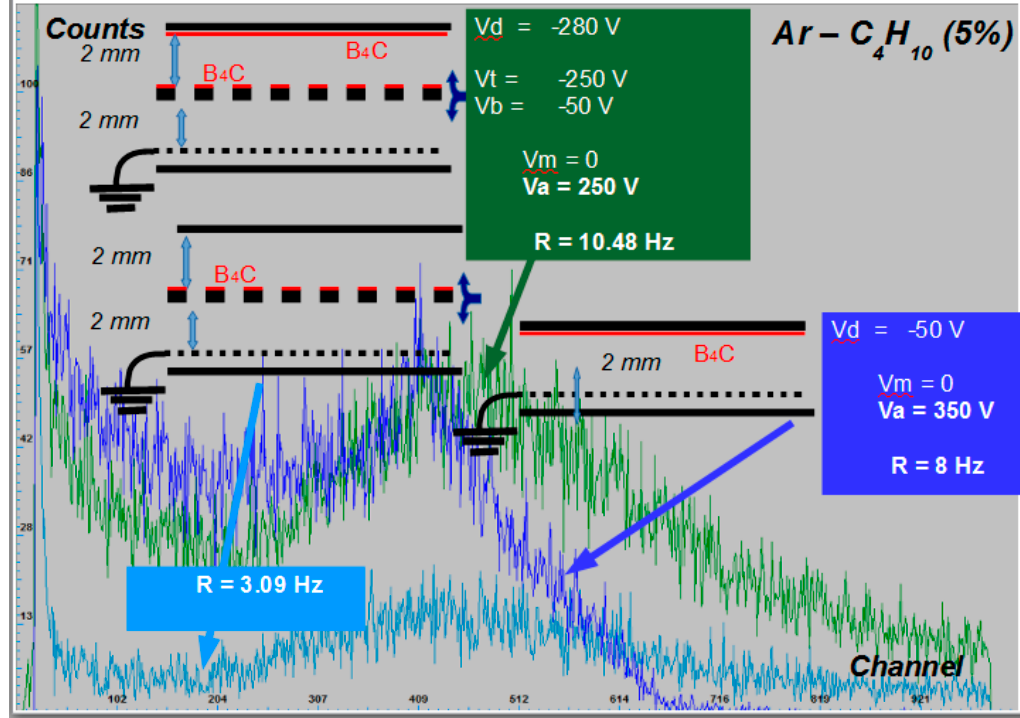
Figure 6 . Data measured during 3000 s for each run, using a gas electron multiplier (GEM)-type Kapton mesh coated with 0.4- μ m 10 B 4 C and for three different configurations.